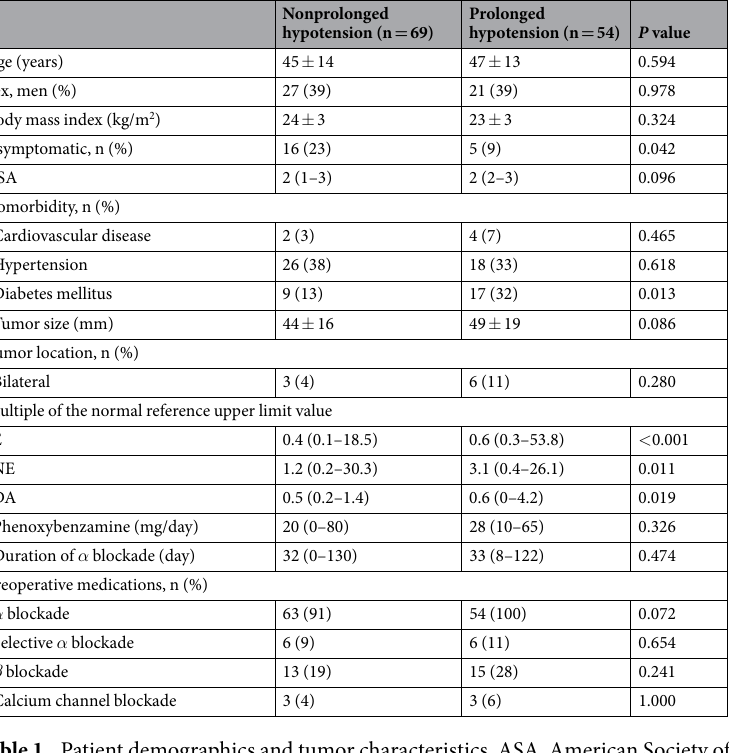
Table 1. Patient demographics and tumor characteristics. ASA, American Society of Anesthesiologists Physical Status Classification System. NE, norepinephrine; E, epinephrine; DA, dopamine.